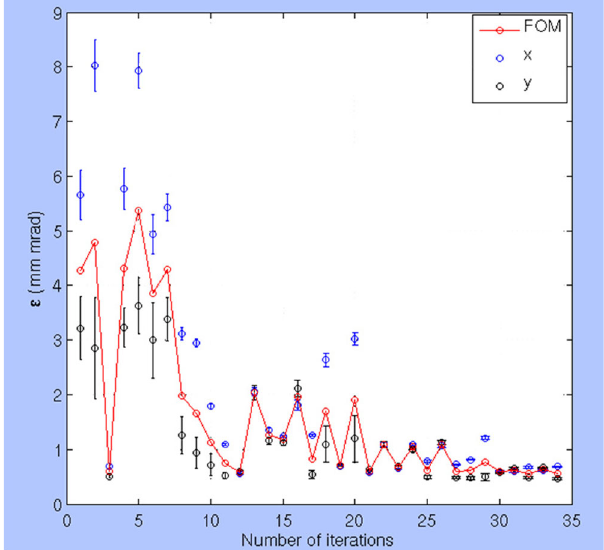
FIG. 17. FOM and horizontal and vertical projected emittances during the optimizer run at